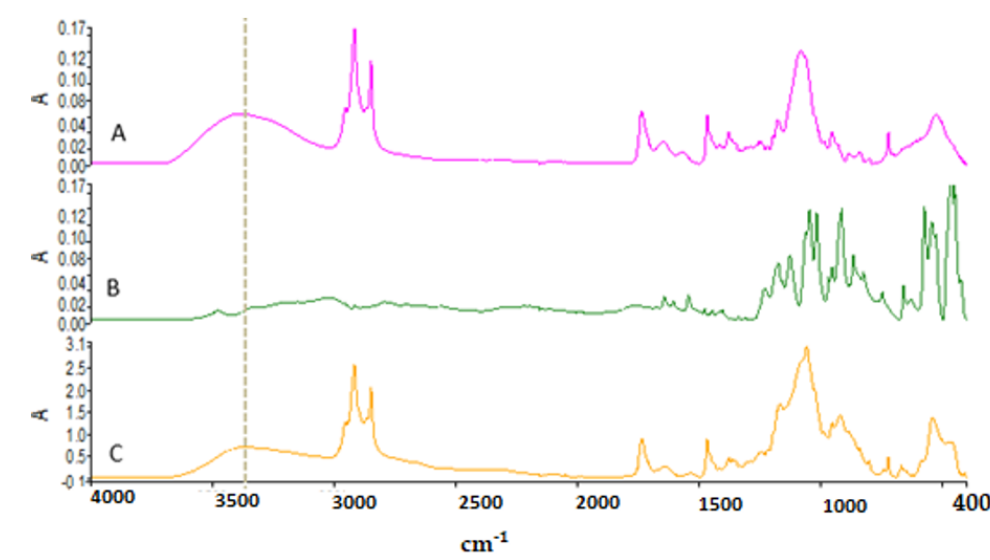
Figure 5. The FTIR spectrum of (A) blank niosome, (B) ALS (C), ALS-loaded niosome.